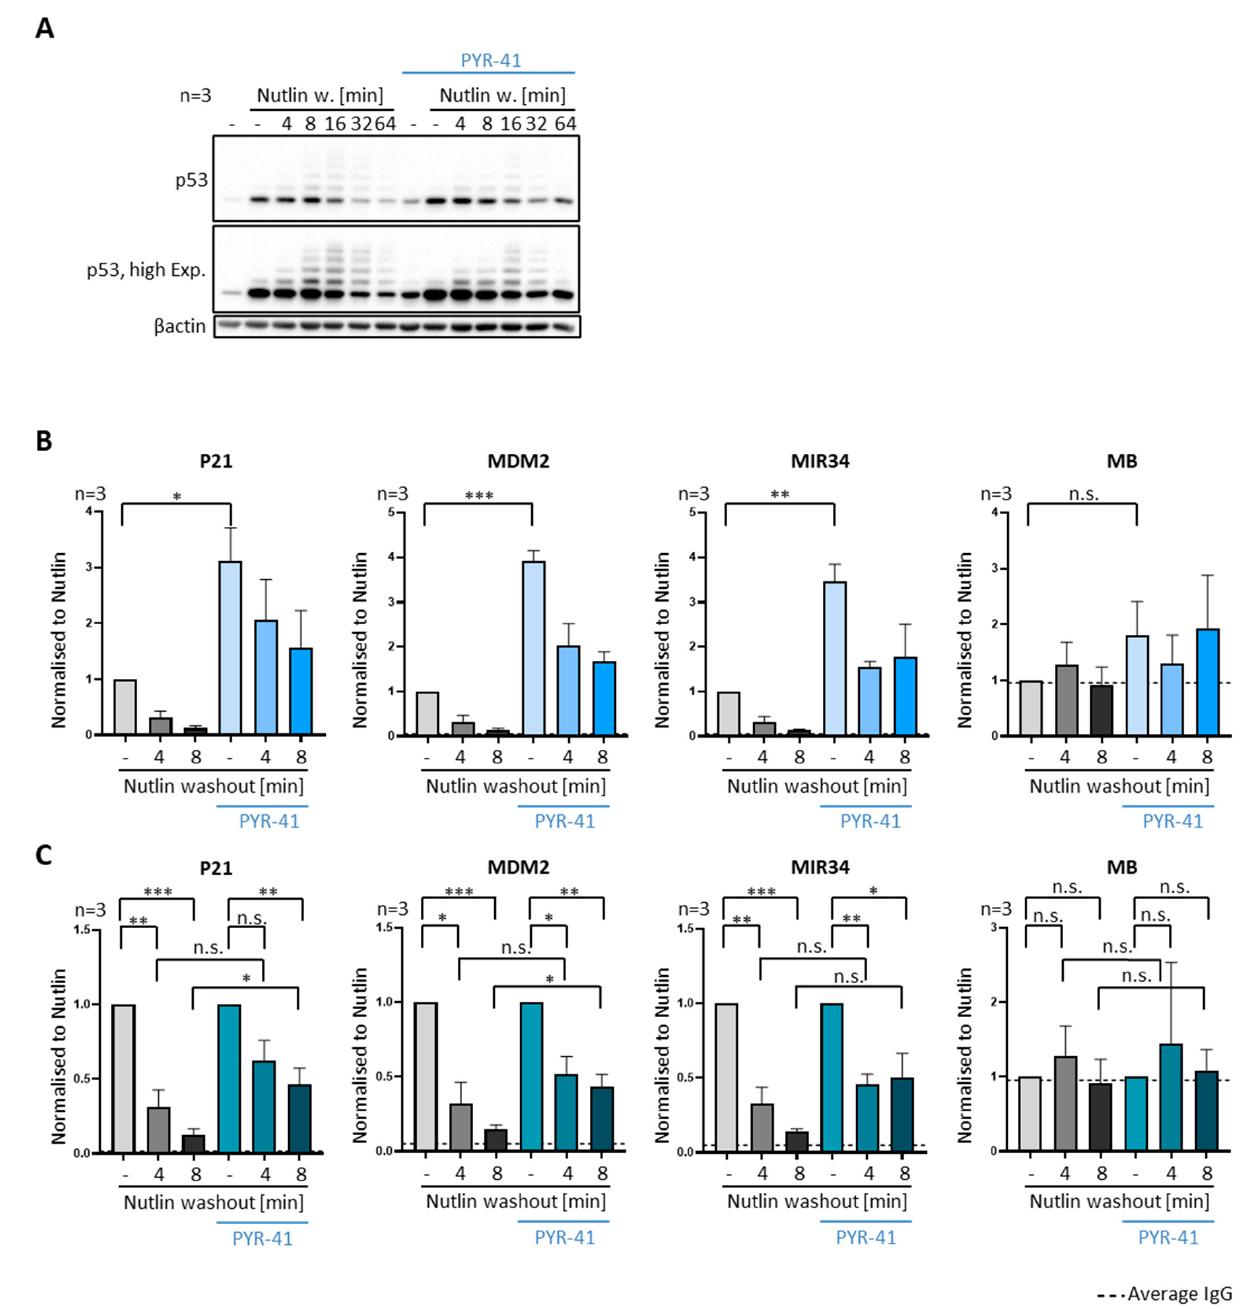
Figure 7. Attenuated p53-removal upon E1 ligase inhibition. ( A – C ) Ubiquitination was inhibited by adding 20 µ M of the E1 ubiquitin activating enzyme inhibitor PYR-41 for 4 h prior to Nutlin washout, with continued treatment after Nutlin removal. ( A ) Immunoblot analysis revealed that p53 ubiquitination and degradation after Nutlin washout is reduced by PYR-41, albeit to a lesser extent than upon prolonged proteasome inhibition (Figure 6A). ( B ) P53 occupancy on promoter DNA, detected by ChIP analysis, was significantly increased upon treatment with PYR-41. The velocity of p53 removal, however, was reduced by PYR-41, as further visualized in ( C ). *** p < 0.001; ** p < 0.01; * p < 0.05; n.s., non-significant. “-“, no Nutlin